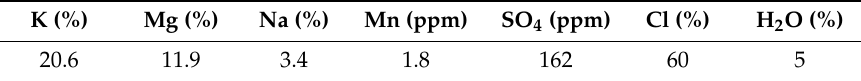
Table 1. Chemical composition of the ternary chloride salt tested.